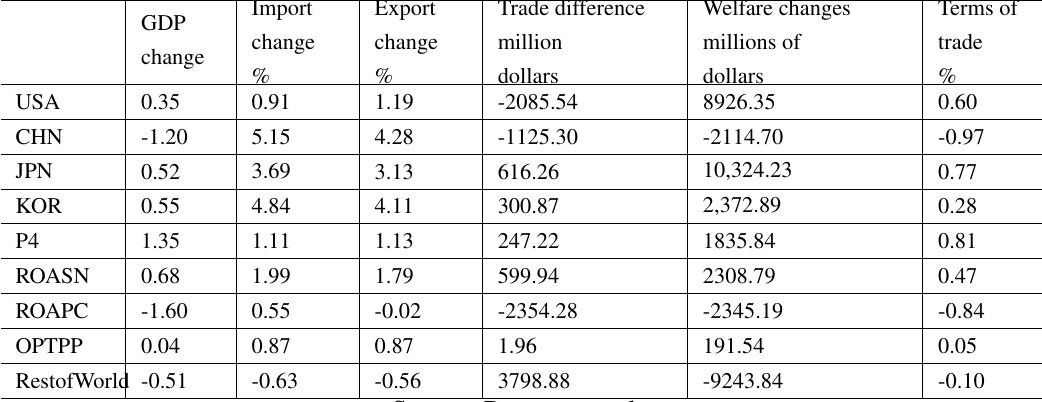
Table 3 The United States attracts all Asia-Pacific countries to join (including